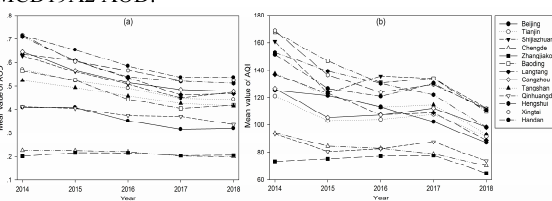
Figure 8. Annual averages AOD and AQI of 13 cities in BTH region from 2014 to 2018